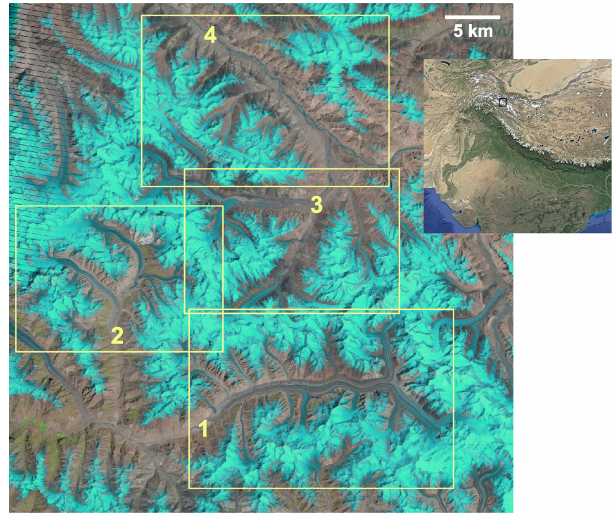
Figure 1. Landsat scene of the study region from 2004 showing footprints of the four subregions depicted in Figs. 2–5. The black square in the inset shows the location of the study region in the Karakoram mountain range (map taken from Google Earth). The image centre is at 36 ◦ N, and 76.3 ◦